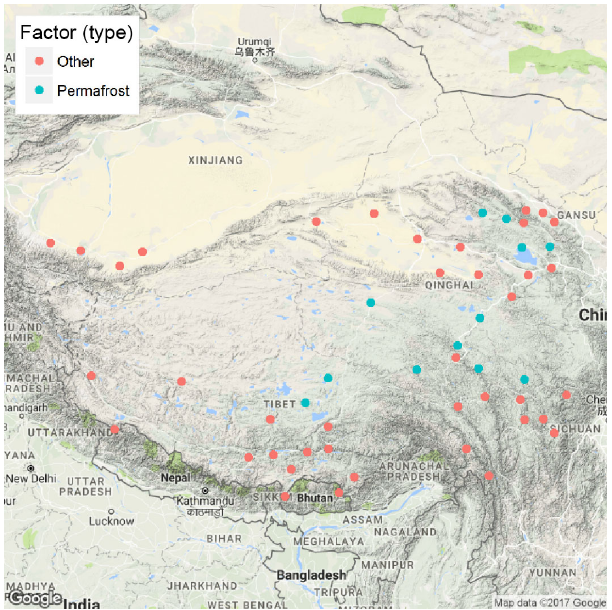
Figure 4. Permafrost occurrence map. Google Maps is a base map that uses the Exist_Permaforst function. “Other” indicates seasonal frozen